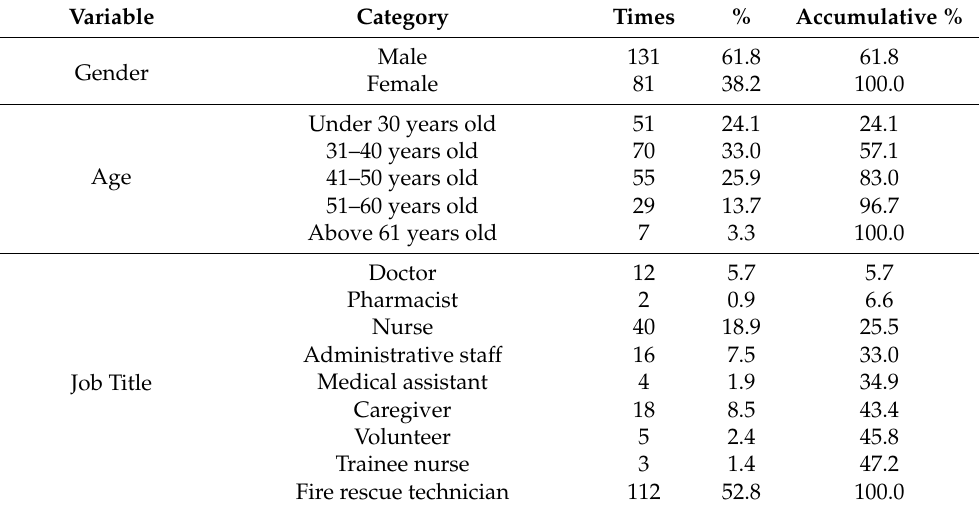
Table 1. Subject